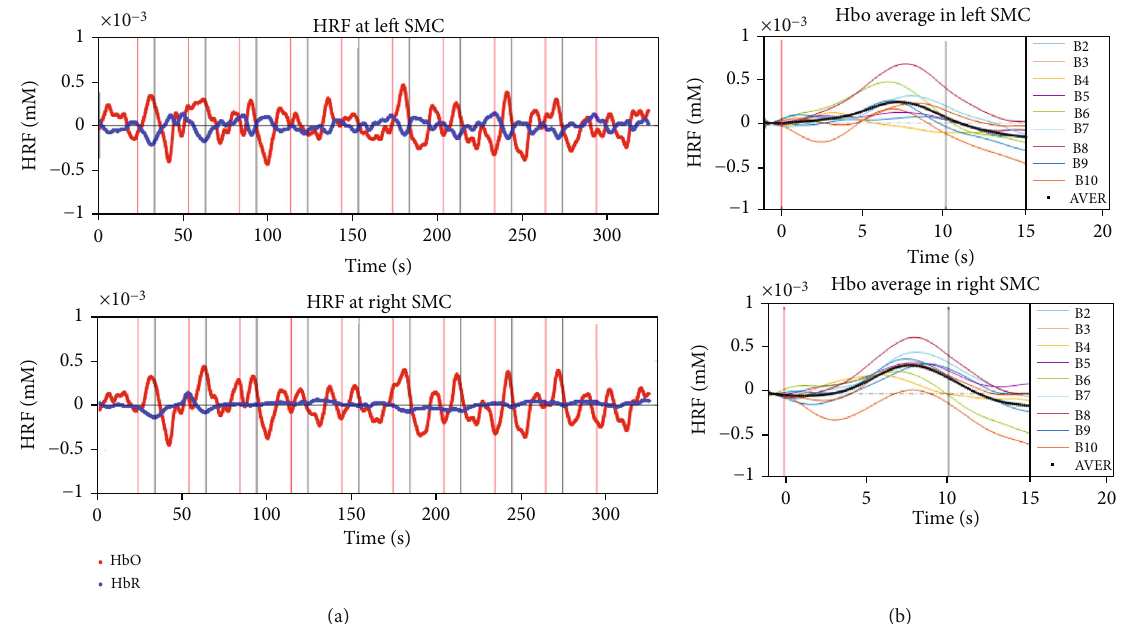
Figure 8: (a) Typical hemodynamic responses in the left and right SMC induced by fast fi nger-tapping exercises and Bi-cTBS/iTBS stimulation. Red and blue plots indicate the fl uctuation of HbO and HbR, respectively; vertical lines indicate the start and stop of the tasks. (b) Block average HbO concentration (black bold plots) from block 2 to block